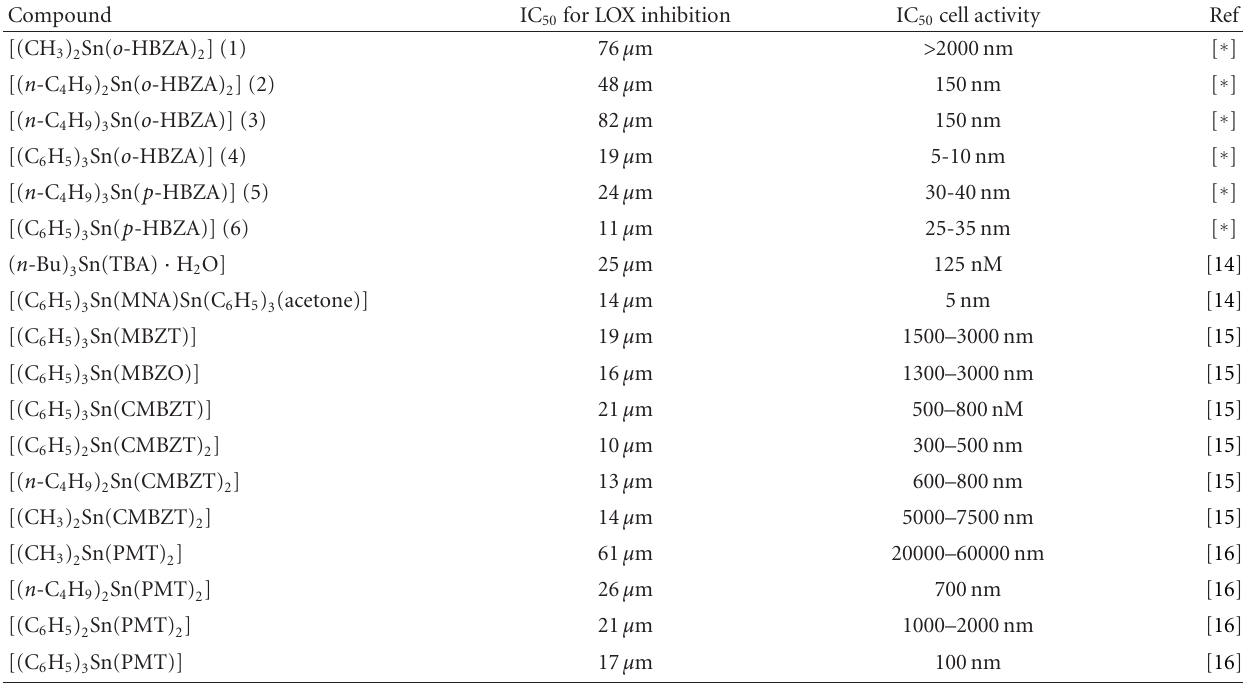
Table 4: IC 50 values for LOX inhibition activity and cell cytotoxic activity of organotin(IV) complexes 1 – 6